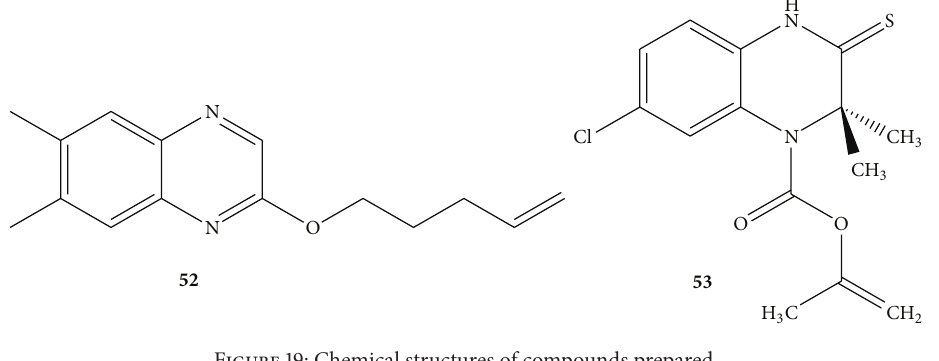
Figure 19: Chemical structures of compounds prepared.